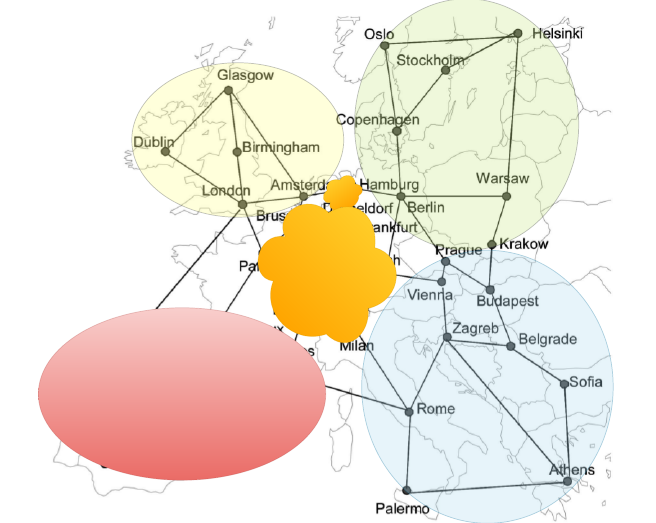
Figure 2. Running community detection on the European Reference network topology (ERnet) yields five communities. Colours followed by pairs of integers denote the names of the communities and the number of inter and intra community links. For example the red community has 4 inter community links and 7 intra-community links, Red (4,7). The remaining communities are summarized: Blue (5,9), Green (4,8), Orange (8,10) and Yellow (4,6).